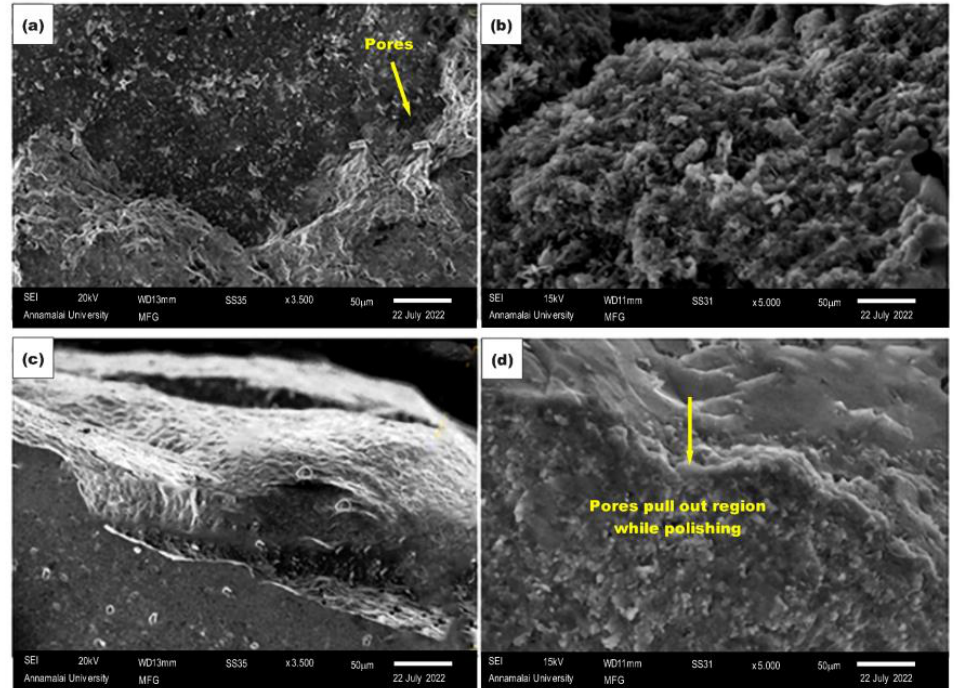
Figure 8. SEM images of the sintered composites: ( a ) TiB 2 -15Si 3 N 4 -3B 4 N, ( b ) TiB 2 -15Si 3 N 4 -6B 4 N, ( c ) TiB 2 -30Si 3 N 4 -3B 4 N, and ( d ) TiB 2 -30Si 3 N 4 -6B 4 N.